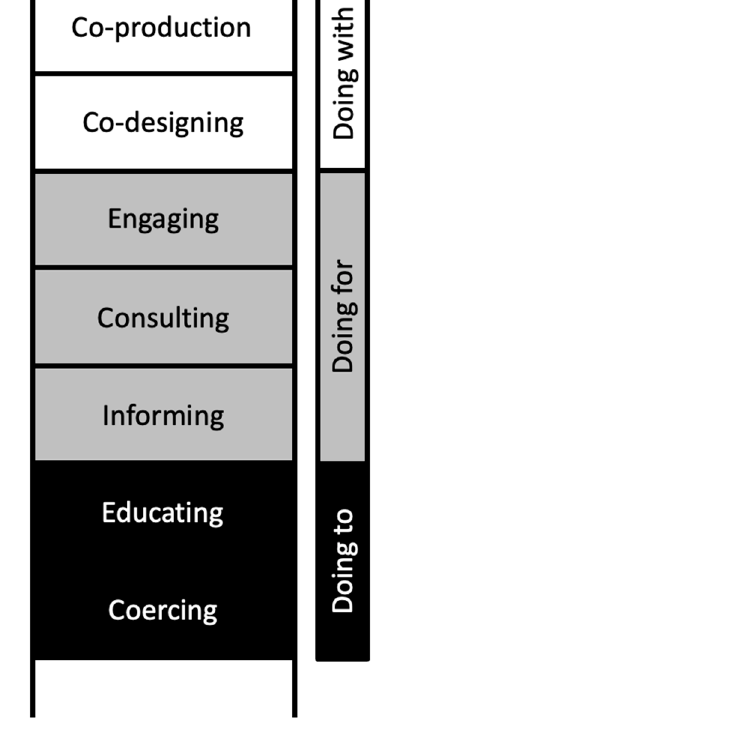
Figure 1. A modified Ladder of Participation to depict the levels of patient participation on mental health service design and delivery. The original Ladder of Participation was first described by Sherry Arnstein in context of citizen participation in 1969 [6]. Building upon Arnstein’s ladder, the new economics forum (nef) adapted the ladder into the context of mental health service delivery in the UK [7].